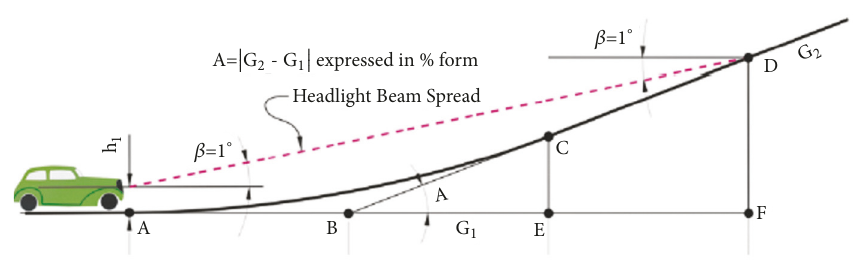
Figure 2: Inclined angle of headlight beam while being on a sag vertical curve [38].